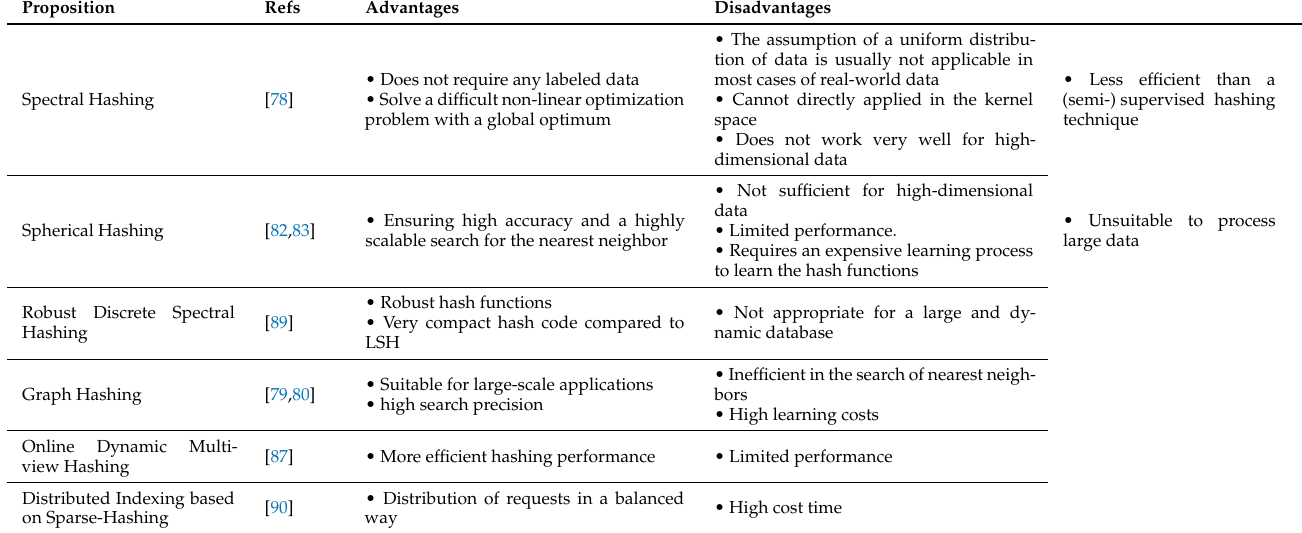
Table 3. Summary of advantage and disadvantage of unsupervised hashing techniques.